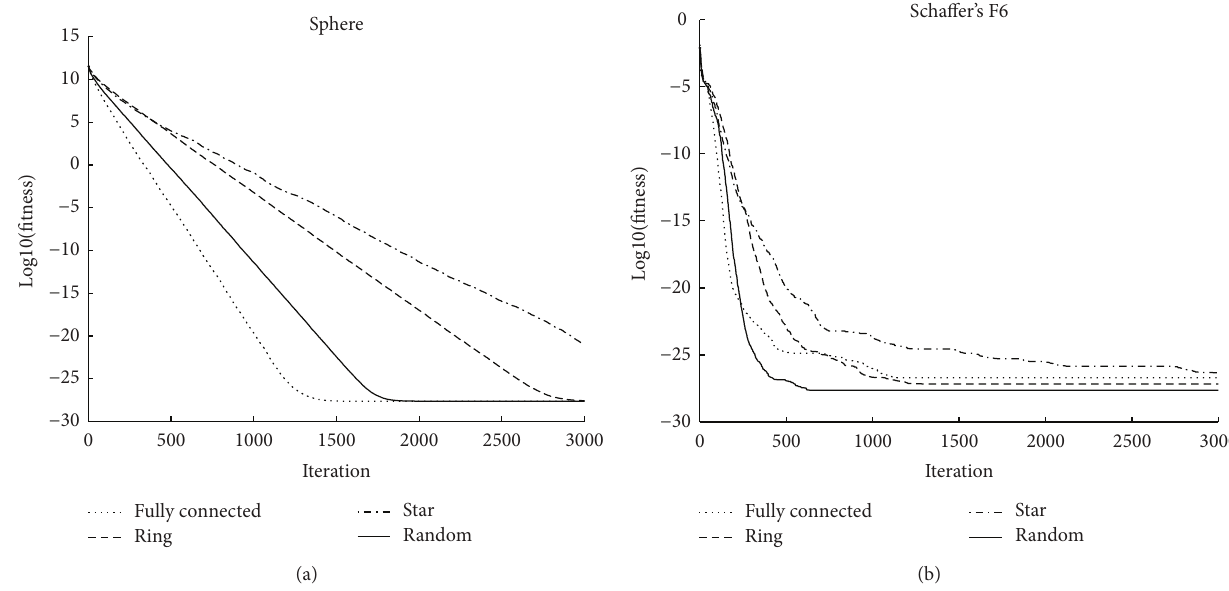
Figure 2: Comparison of evolutionary trend between four topologies (Sphere and Schaffer’s F6).